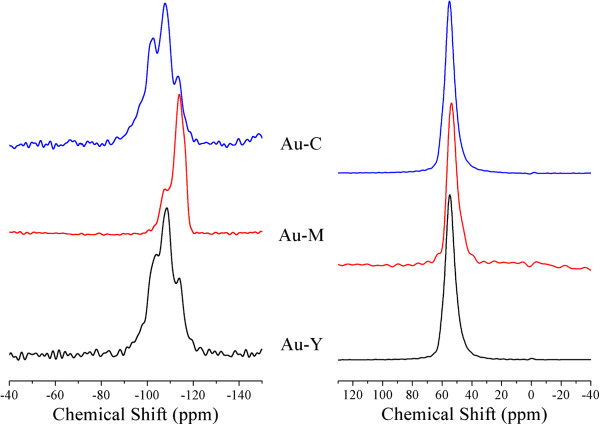
On the left, 29Si MAS NMR spectra and on the right the 27Al MAS NMR spectra acquired at 79.46 and 104 MHz, respectively.